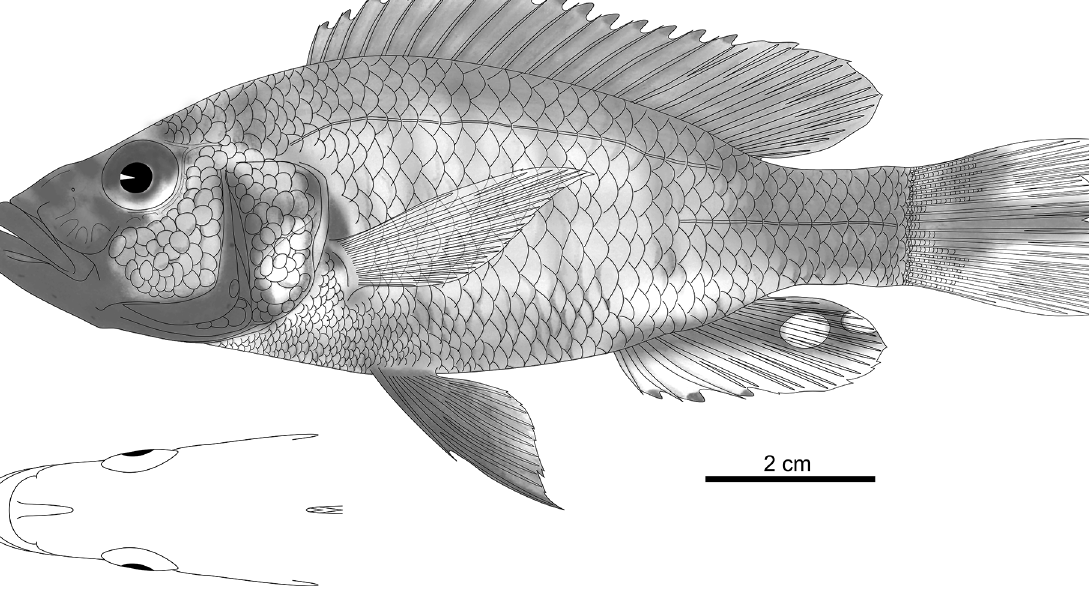
Fig. 17. Haplochromis glaucus sp. nov., holotype, ♂, 106.2 mm SL (RMCA 2019.002.P.0016). Drawn by N.